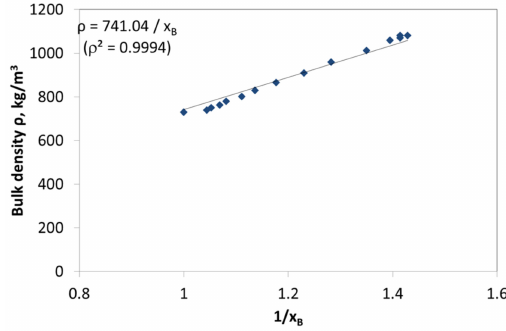
Figure 6. Bulk density of crushed briquettes after Shatter Test drop tests against the inverse yield of briquettes above 40 mm.